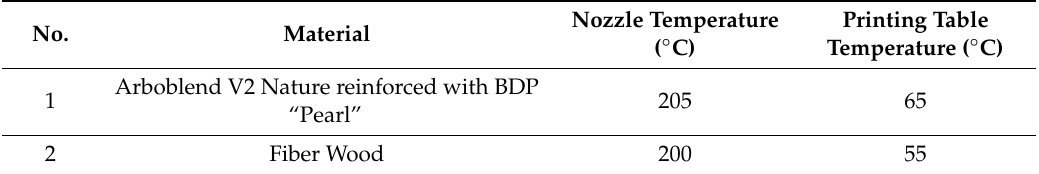
Table 2. The temperatures of extrusion nozzle and printing table, for the two prototyped materials. Nozzle Temperature Printing Table No. Material ( ◦ C) Temperature ( ◦ C) Arboblend V2 Nature reinforced with BDP 205 65 1 “Pearl” 2 Fiber Wood 200